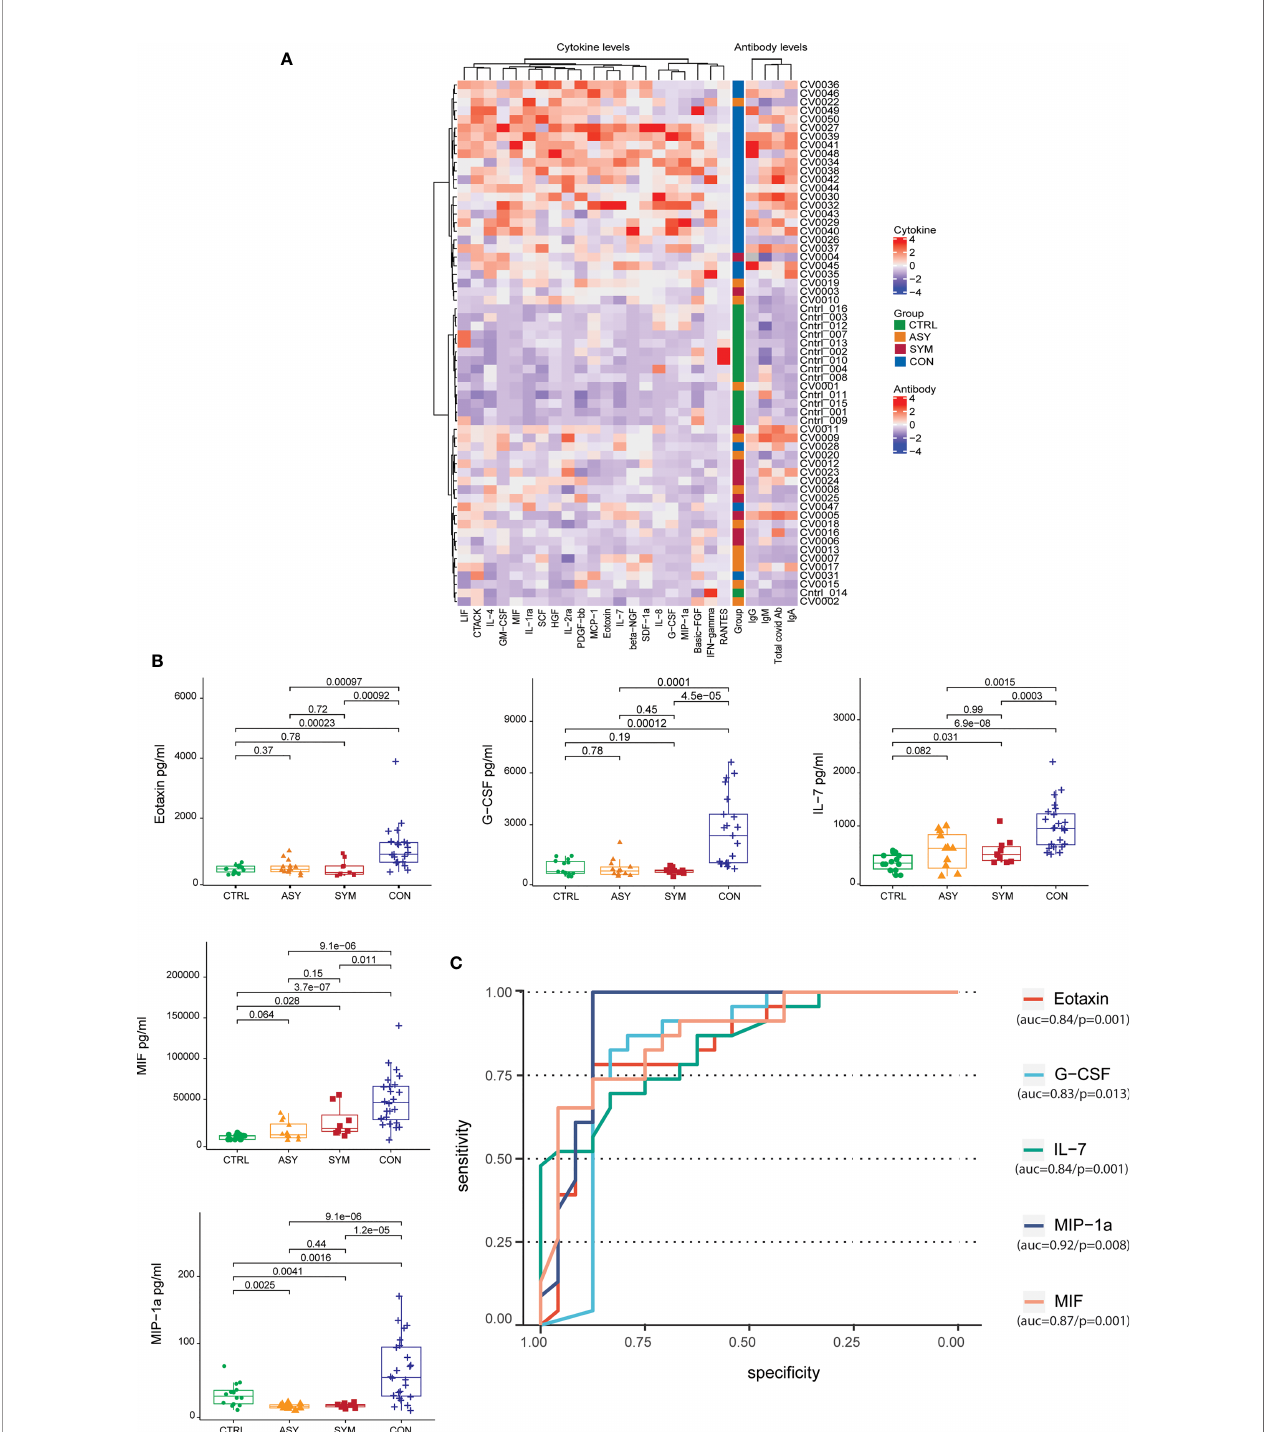
FIGURE 2 | Unsupervised hierarchical clustering of antibodies and cytokines and cytokine levels with contrast of differentiation across subject groups. (A) Heatmap depicting the grouping (row-wise clustering) of individuals based on the abundance of 21 cytokines in serum and the respective antibody levels. The column-wise clustering portrays the overall coexpression of cytokines. Both row-wise clustering and column-wise hierarchical clustering were performed using Ward D method with 500 bootstraps. (B) Box plots depicting the serum cytokine levels in pg/ml (Eotaxin, G-CSF, IL-7, MIF, and MIP-1 a ) determined by Bio-Plex along with the (C) the area under the receiver-operating characteristic (ROC) curve of the cytokines having more than 0.8 AUC, taking 14 controls, 10 symptomatic, and 13 asymptomatic patients along with 24 contacts. Statistical comparisons were performed using unpaired Wilcoxon test; p-values are written against respective